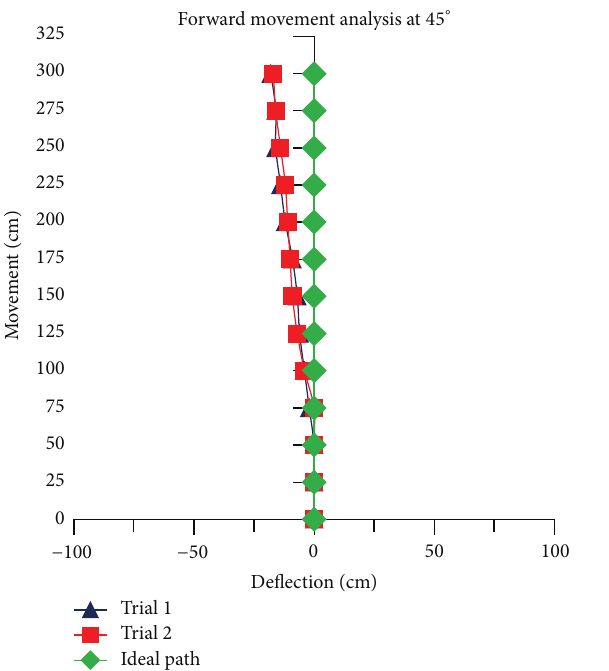
Figure 13: Forward movement versus deflections at 𝜃 = 60 ∘ .